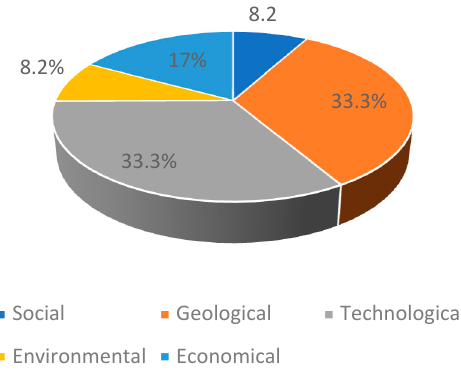
Figure 1. Sensitivity of the final score result on each criterion.